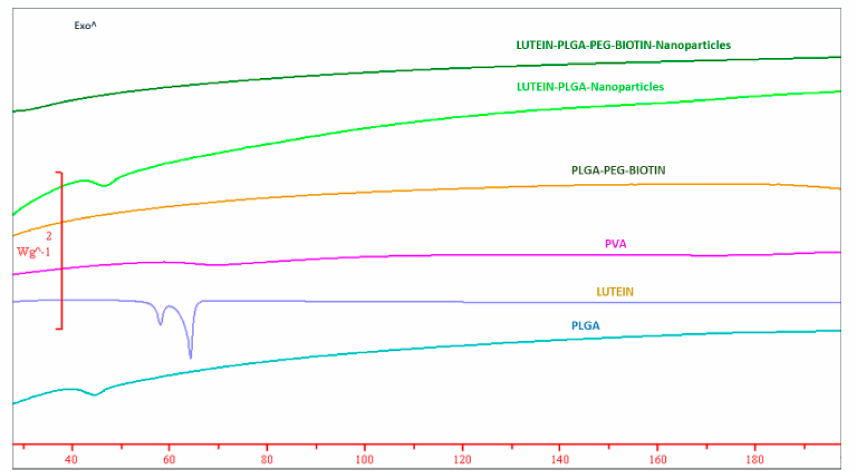
Figure 3. DSC thermograms of lutein-loaded PLGA–PEG–biotin nanoparticles, lutein-loaded PLGA nanoparticles, PLGA–PEG–biotin, PVA, lutein, and